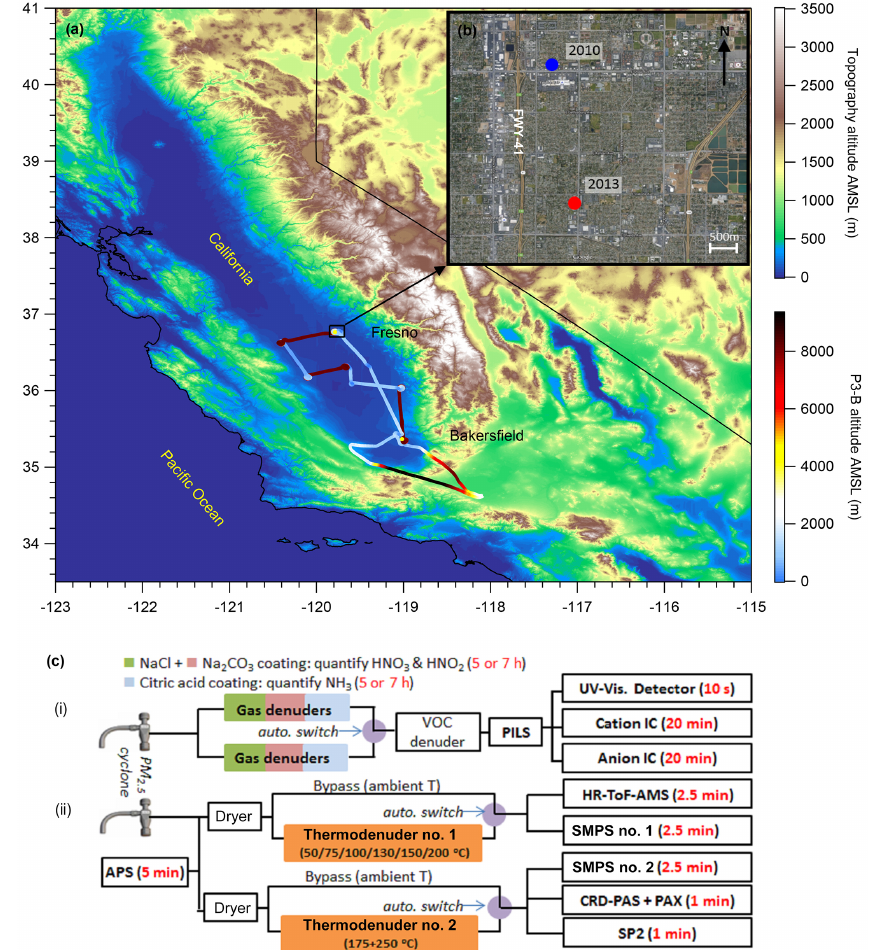
Figure 1. (a) Topographical map of the San Joaquin Valley (SJV) of California and NASA P-3B flight tracks during the winter 2013 DISCOVER-AQ campaign; (b) the inset shows the location of the supersite in Fresno from winter 2013 (denoted by the red circle) and the location of a similar campaign that took place in winter 2010 (Ge et al., 2012a, b) (denoted by the blue circle); (c) setup of the real-time instruments deployed at the Fresno supersite. (i) A particle-into-liquid sampler (PILS) was coupled with two ion chromatographs (IC) and a UV–vis detector. The PILS sampled after a fresh set of three annular denuders every 5 or 7h; (ii) After a PM 2 . 5 inlet, the flow was split into three paths: the first path included the high-resolution time-of-flight aerosol mass spectrometer (HR-ToF-AMS) and a scanning mobility particle sizer (SMPS) which sampled alternatively through a bypass line and a thermodenuder (TD). The second path included a SMPS, a cavity ring-down photoacoustic spectrometer (CRD-PAS) and particle extinctometer (PEX), and a single particle soot photometer (SP2). A TD was used to volatilize aerosol at 175 ◦ C then 250 ◦ C. The third path led to an aerodynamic particle sizer